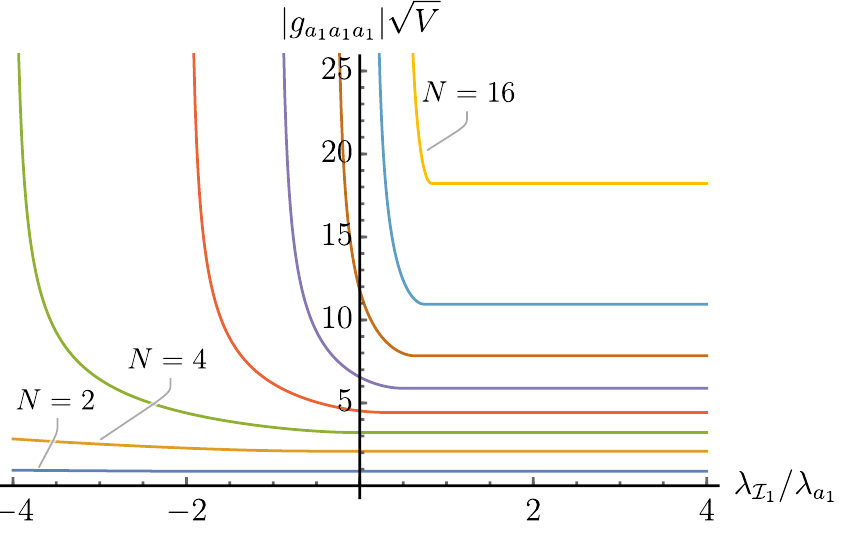
jp V as a function of (cid:21) I 1 a 1 a 1